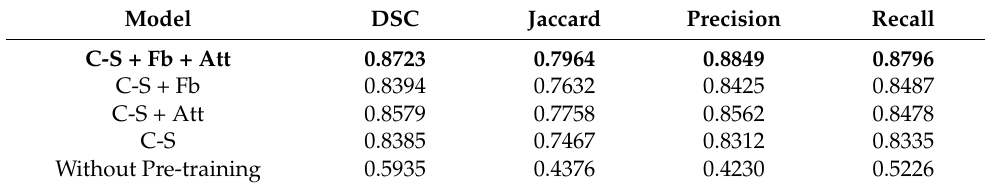
Table 4. Results of ablation experiments. Each abbreviation in the first column stands for C-S (Cooperative segmentation), Att (Attention mechanism), and Fb (Feedback mechanism). We use four metrics, DSC, Jaccard, precision, and recall, to evaluate the performance of segmentation with different combinations of